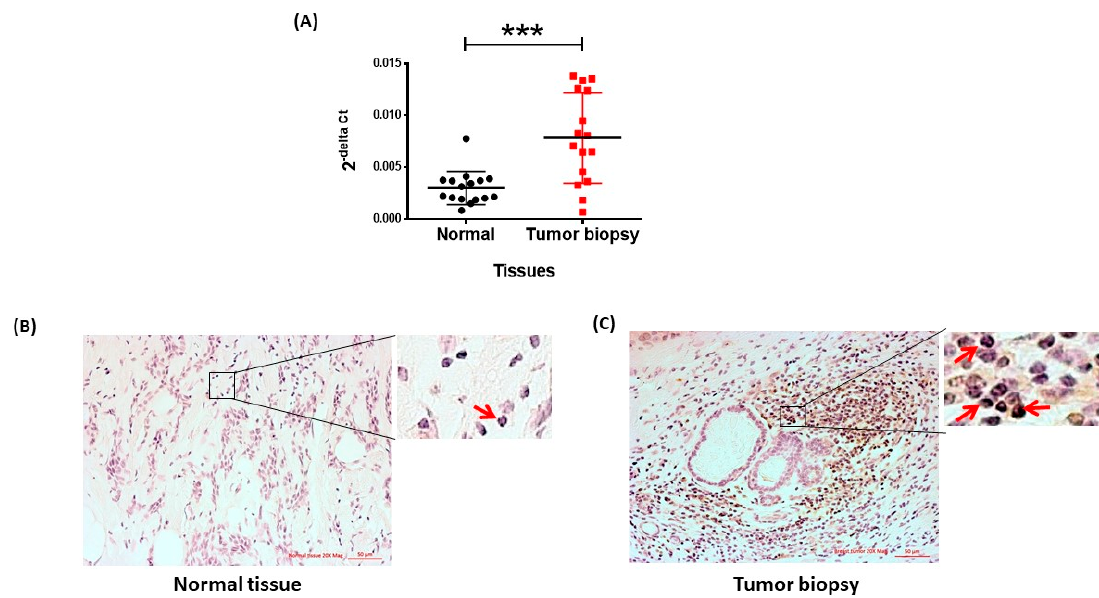
Figure 3. MCM10 expression in patient tumor biopsy. ( A ) MCM10 expression quantified by qPCR in paired normal and tumor biopsy samples ( n = 16, *** p = 0.006); ( B , C ) immunohistochemistry staining of patients’ biopsy, High MCM10 DAB staining is observed in patients’ biopsies; ( C ) compared to normal breast tissue ( B ). Magnified images showing nuclear staining of MCM10, in red arrows.